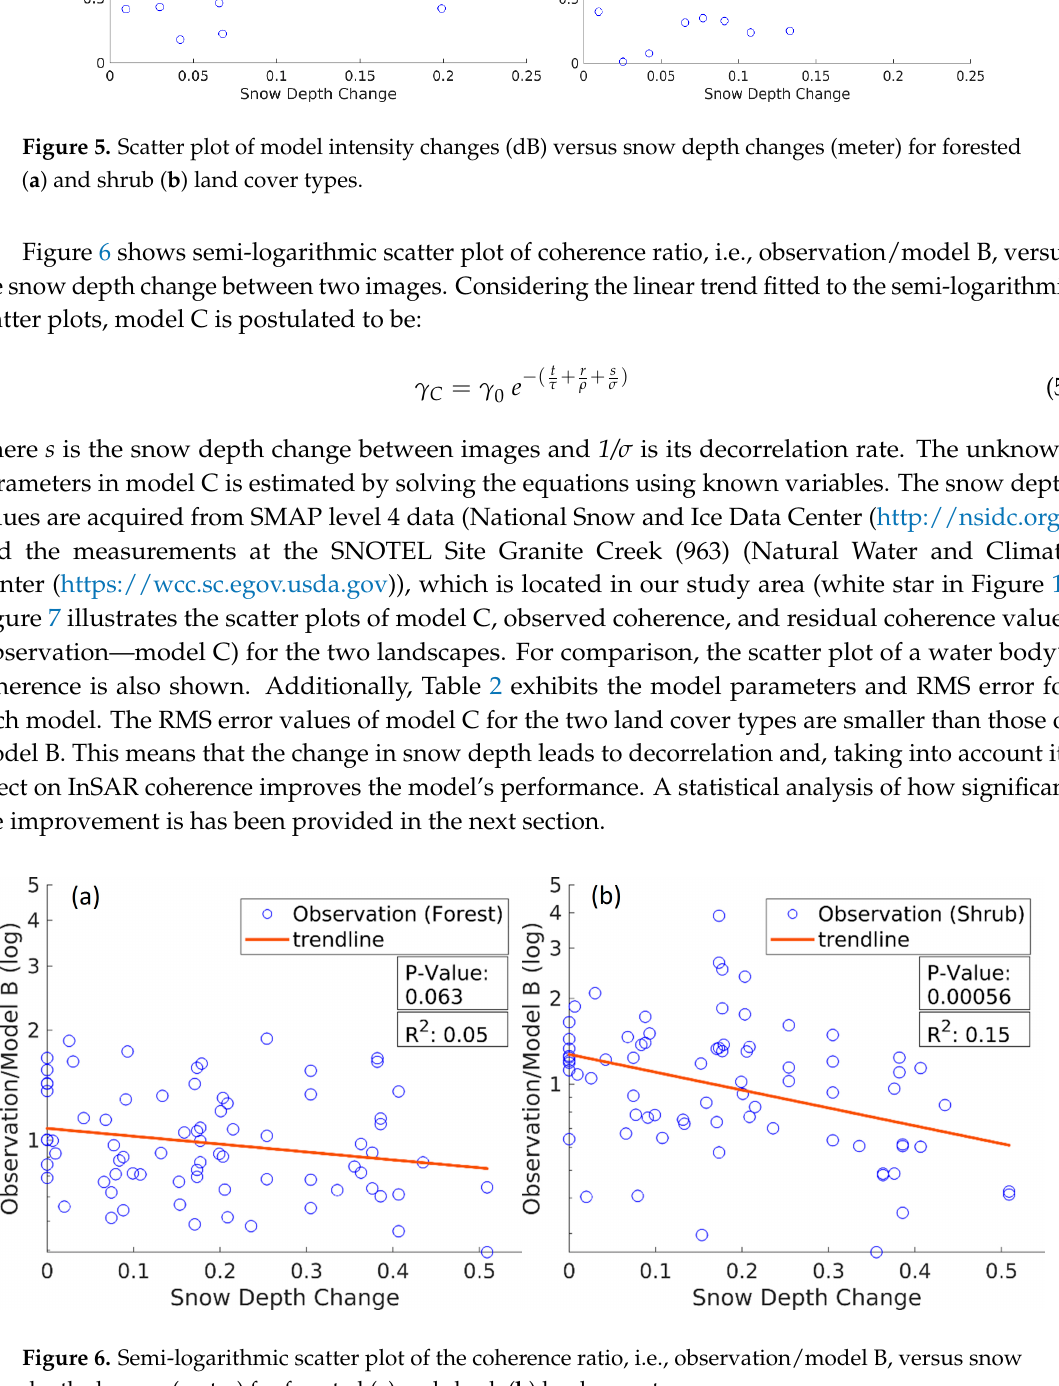
Figure 7. Scatter plots of observations and model C for forested ( a ) and shrub ( c ) land cover types. Scatter plots of residual coherences (observation—model C) for forested ( b ) and shrub ( d ) land cover types. Plot of model A and the scatter plot of coherence of water body are shown for comparison 4. Discussion 4.1. Scatterers’ Type and Decorrelation Sources Model C has three terms. The first term, exp ( − t/ τ ) , is the long-term irreversible decorrelation due to the temporal change in scatterers’ geometry. The second term, exp ( − r/ ρ ) , is the decorrelation due to the changes in backscattering between two images. As stated earlier, the change in SAR intensity